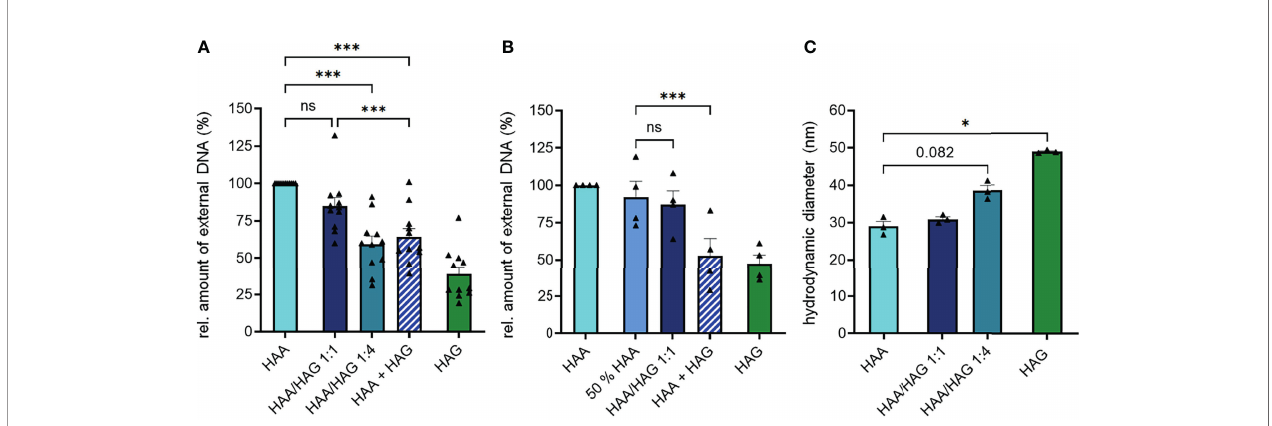
FIGURE 2 | IgG does not increase IgA-induced NET formation in IgA/IgG mixed complexes. (A) Isolated human blood neutrophils were stimulated with 150 µg/ml heat-aggregated IgA (HAA), heat-aggregated IgG (HAG), IgA/IgG mixed complexes in different ratios (HAA/HAG 1:1 or 1:4) or 75 µg/ml heat-aggregated IgA plus 75 µg/ml heat-aggregated IgG (HAA + HAG). NET formation was measured by staining extracellular DNA with Sytox Green. Shown are relative amounts of extracellular DNA 270 min after stimulation normalized on HAA treatment. N = 11 donors. (B) NET formation of human neutrophils with 150 µg/ml heat-aggregated IgA (HAA), heat-aggregated IgG (HAG), IgA/IgG mixed complexes at 1:1 ratio (HAA/HAG 1:1), 75 µg/ml heat-aggregated IgA (50% HAA) or 75 µg/ml heat-aggregated IgA plus 75 µg/ml heat-aggregated IgG (HAA + HAG). Shown are relative amounts of extracellular DNA 270 min after stimulation normalized on HAA treatment. N = 4 donors. (C) Hydrodynamic diameter of Ig complexes measured with dynamic light scattering. N = 3. Data are presented as scatter plots with bars showing mean and SEM. Signi fi cance was tested with repeated measures one way ANOVA with Geisser Greenhouse correction and S ̌ ı ́ da ́ k ’ s multiple comparisons post hoc test. *p < 0.05; and ***p < 0.001. ns, not signi fi